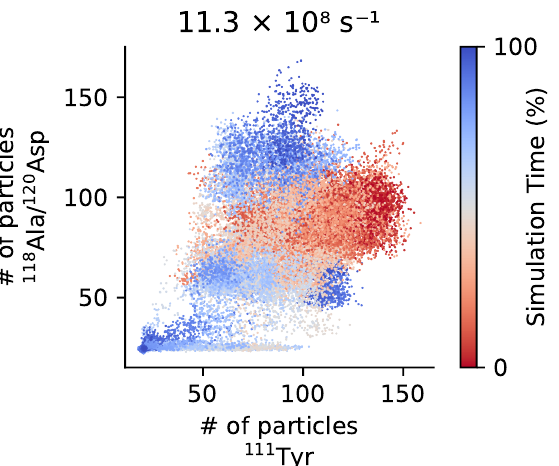
Figure 7. Exposure of the cleavage and the recognition sites of A2 domain under shear. The trajectories of shear unfolding ( ˙ γ = 11.3 × 10 8 s − 1 ) are projected as a scatter plot on the 2D space of the coordination number of 111 Tyr (cleavage site) and that of 118 Ala/ 120 Asp (recognition site). The sequential exposure of the recognition site before the cleavage site can be appreciated. Trajectories are colored according to progress from red (beginning) to blue